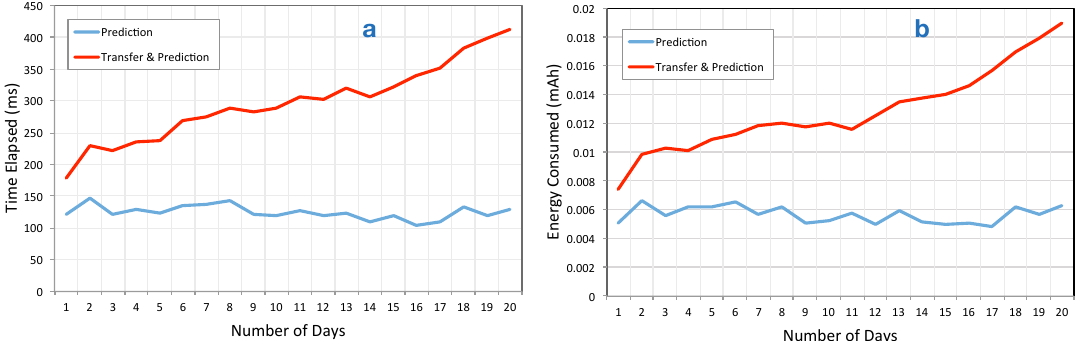
Figure 9. ( a ) The execution time differences while running the algorithm on the device (blue) versus transferring it to the phone and running it there, i.e. , baseline (red); ( b ) the battery consumption in mAh between the baseline versus our on device prediction